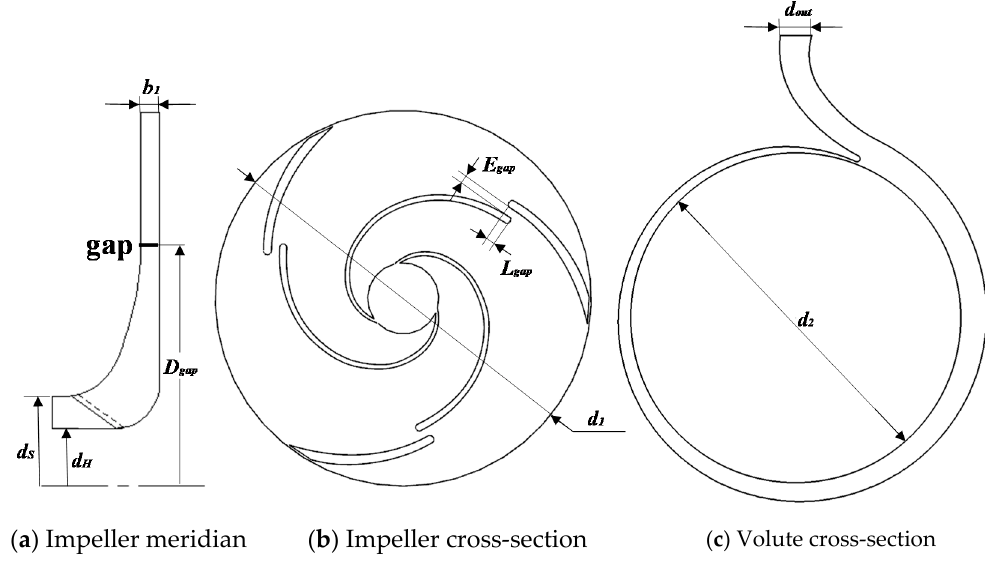
Figure 1. Two-dimensional schematic diagram of the impeller and volute. Table 1. Geometric specifications of the impeller and volute.